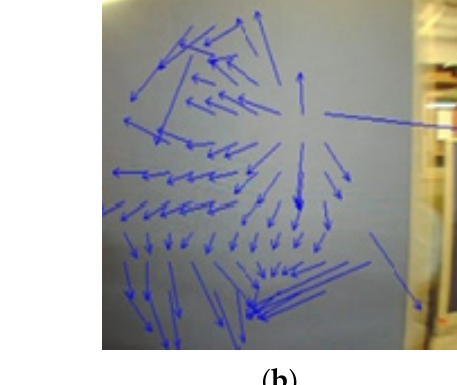
Figure 1. Comparison of point distribution for evaluating optical flow. ( a ) Harris corner points se- lection; ( b ) uniformly distribute points.